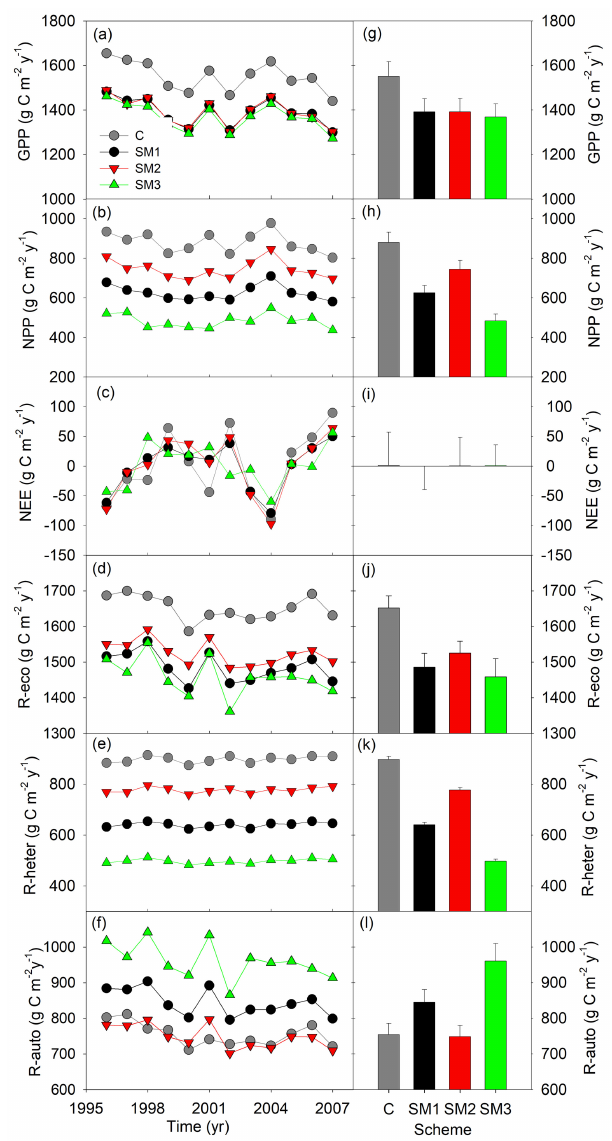
Figure 4. Simulated annual (a–f) and mean (g–l) carbon fluxes from the carbon-only version and carbon–nitrogen coupled with three schemes (SM1, SM2, and SM3) of the TECO model for 1996 to 2007 at Duke Forest. GPP: gross primary productivity; NPP: net pri- mary productivity; NEE: net ecosystem exchange of CO 2 ; R-eco: ecosystem respiration; R-heter: heterotrophic respiration; R-auto: autotrophic